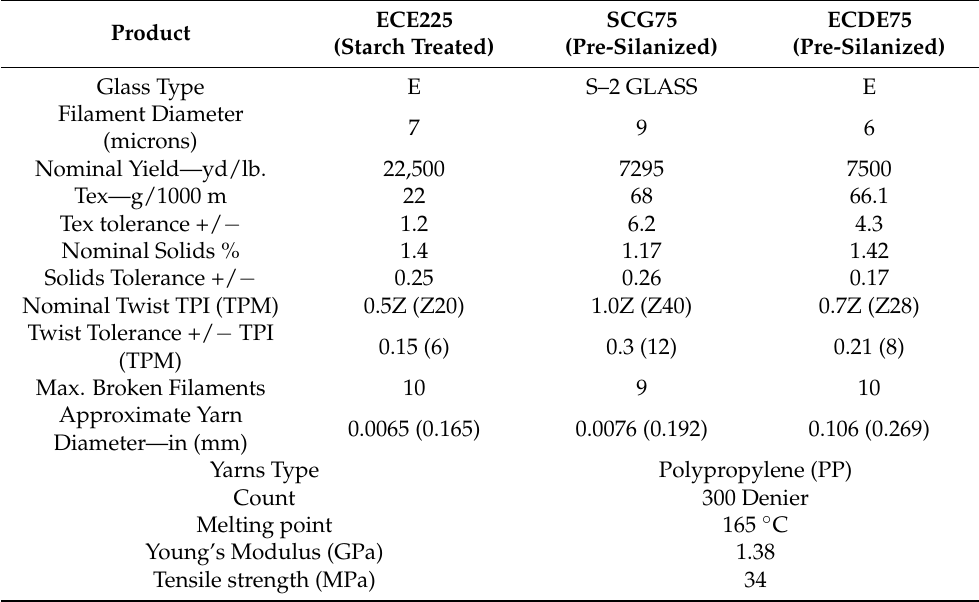
Table 1. Glass fibers and polypropylene yarns